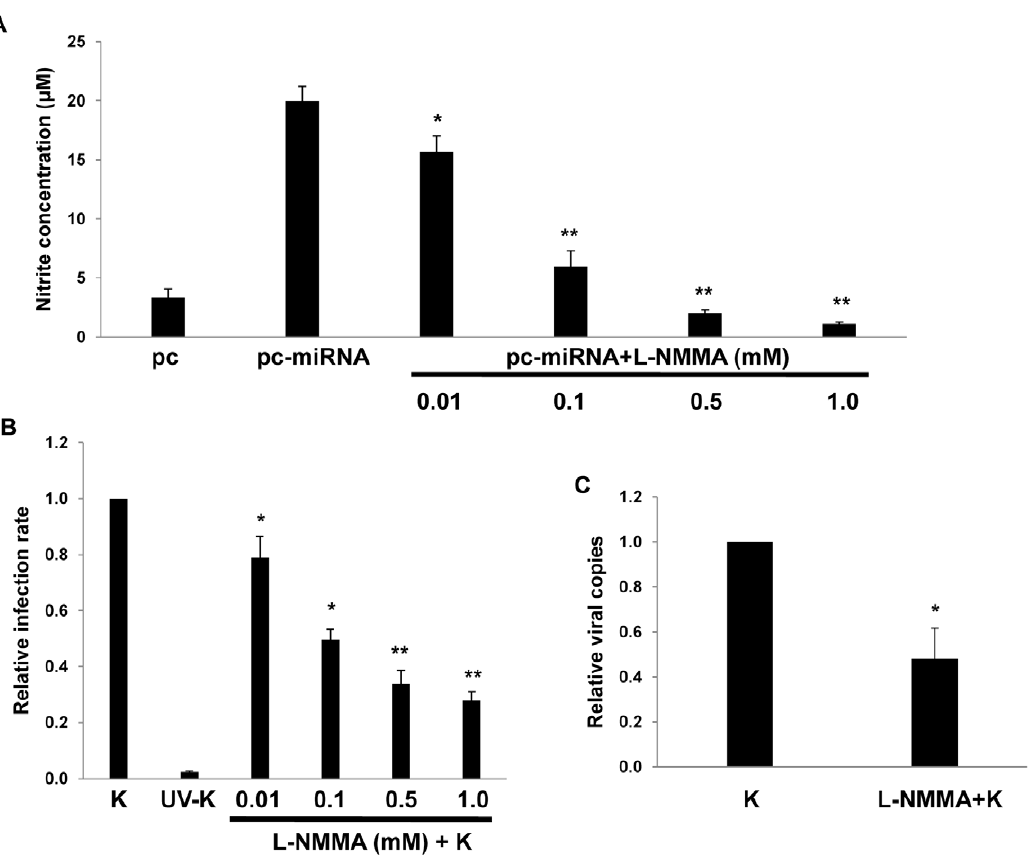
Figure 8. RNS inhibition reduces macrophage susceptibility to KSHV infection. ( A ) RAW cells were first transfected with 1 m g of either control or miRNA-expressing vectors then incubated with L-NMMA for 12 h prior to nitrite quantification in culture supernatants. ( B ) Cells were incubated with L-NMMA for 12 h prior to their incubation with purified KSHV (K) for 2 h. Following an additional 12 h, LANA IFA were performed and relative infection rates determined as described in Methods. ( C ) qPCR was used to determine relative intracellular KSHV DNA content for KSHV- infected cells pre-treated with either vehicle or 0.5mM L-NMMA. In all assays, error bars represent the S.E.M. for three independent experiments. *=p , 0.05, * *=p ,